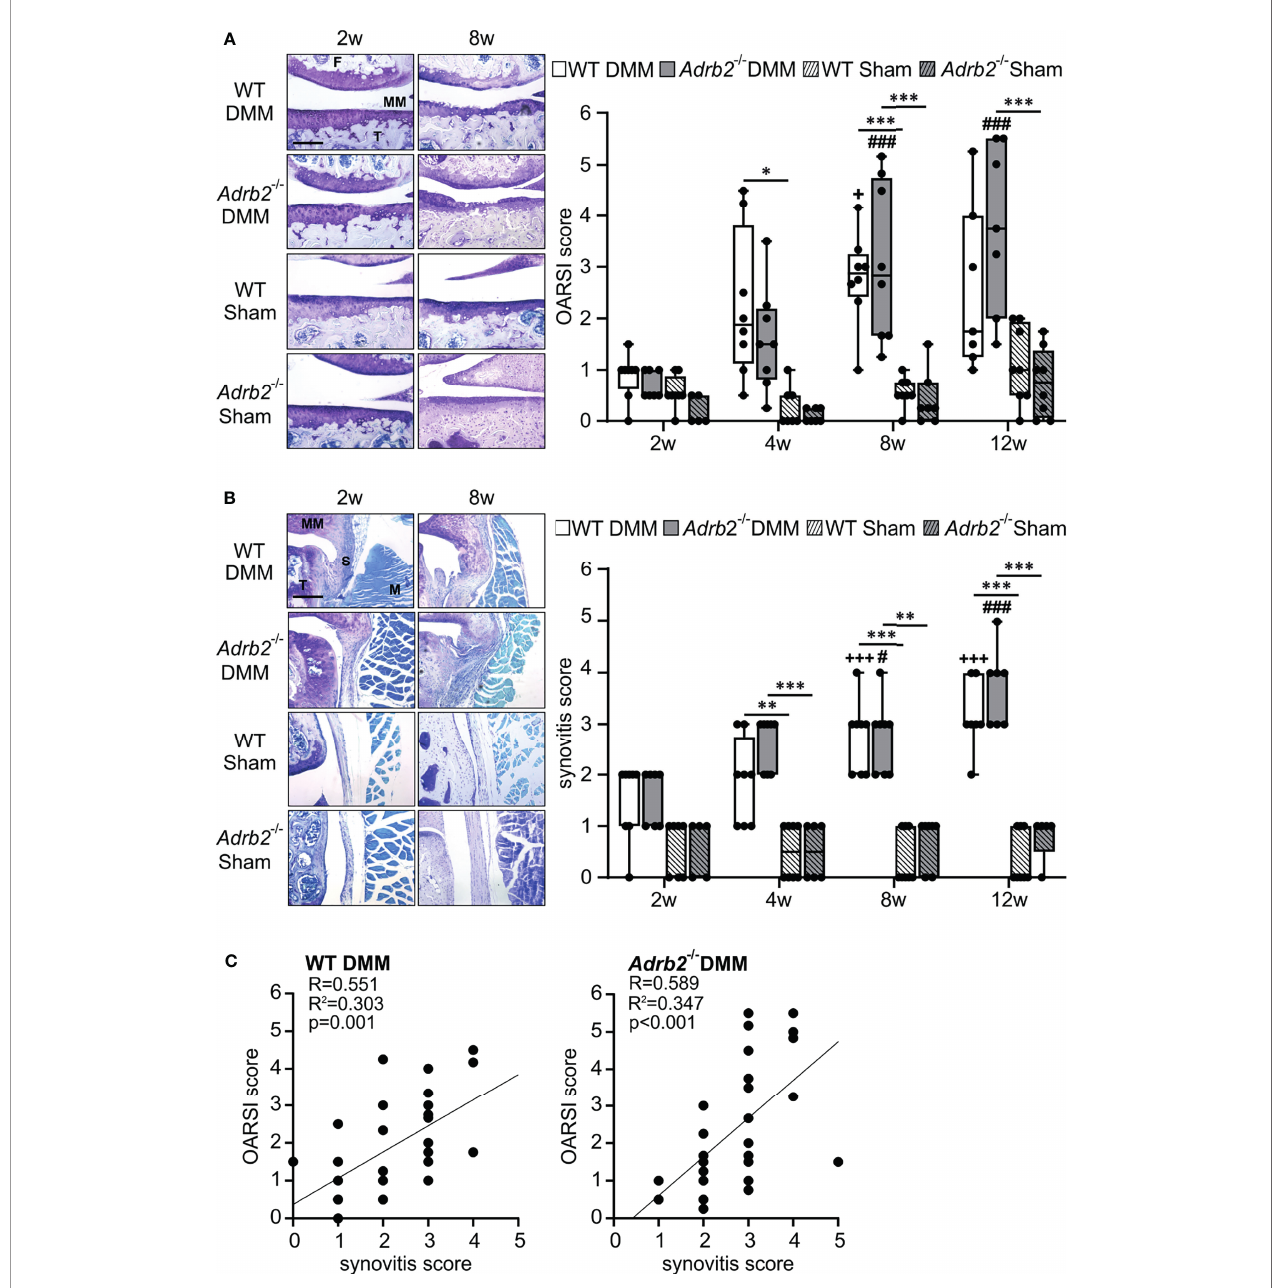
FIGURE 1 | Time course of cartilage degeneration and synovial in fl ammation following DMM. (A) Histological analysis and OARSI scores of the medial tibiofemoral articular cartilage contact area using DMMB staining in WT and Adrb2 -/- mice 2, 4, 8, and 12 weeks after DMM or Sham surgery (bar: 200 µm). Data are presented as box plots with whiskers. Each black circle represents an individual mouse (n=5-8 per group). Signi fi cant p- values are presented as * p ≤ 0.05, ***p ≤ 0.001 for comparisons between groups at one time point; ### p ≤ 0.001 when compared to 2 weeks Adrb2 -/- DMM. No signi fi cance differences observed between WT DMM and Adrb2 -/- DMM. (B) Histological appearance of the synovial tissue and synovitis score in WT and Adrb2 -/- mice 2, 4, 8, and 12 weeks after DMM or Sham surgery (DMMB staining, T: tibia, S: synovium, MM: medial meniscus, M: muscle; bar: 200 µm). Data are presented as box plots with whiskers. Each black circle represents an individual mouse (n=5-8 per group). Signi fi cant p-values are presented as **p ≤ 0.01, ***p ≤ 0.001 for comparisons between groups at one time point; +++ p ≤ 0.001 when compared to 2 weeks WT DMM; # p ≤ 0.05, ### p ≤ 0.001 when compared to 2 weeks Adrb2 -/- DMM. (C) Linear regression of articular cartilage damage (OARSI score) and synovial in fl ammation (synovitis score) in WT and Adrb2 -/- mice 2, 4, 8, and 12 weeks after DMM